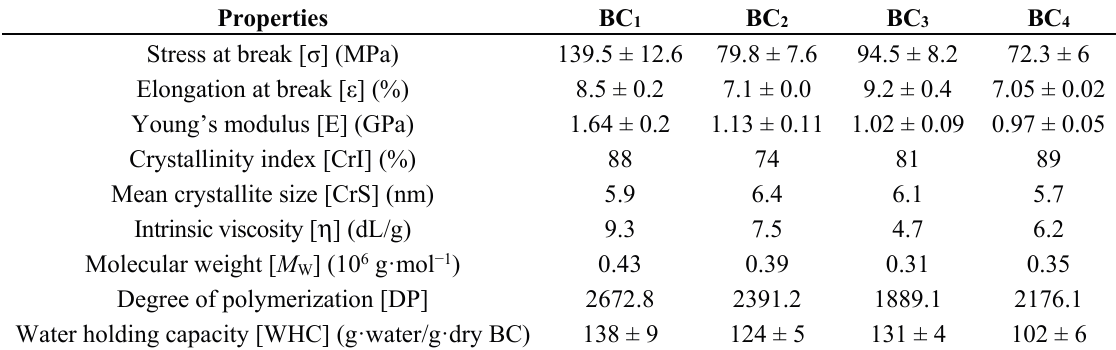
Table 2. Properties of bacterial cellulose